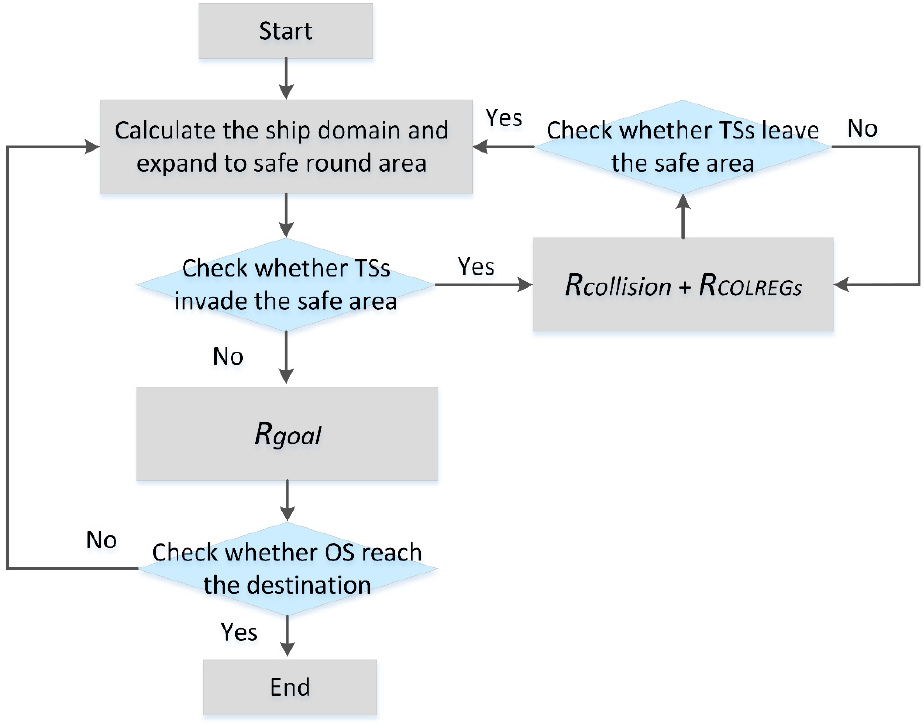
Figure 10. QMIX algorithm for the multi-ship collision avoidance.